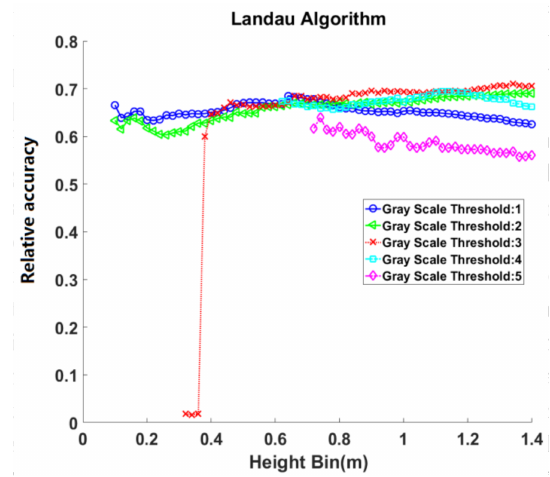
Figure 16. The relative accuracy of Landau algorithm under different height bins and gray scale thresholds in single-scan mode of the natural secondary forest.